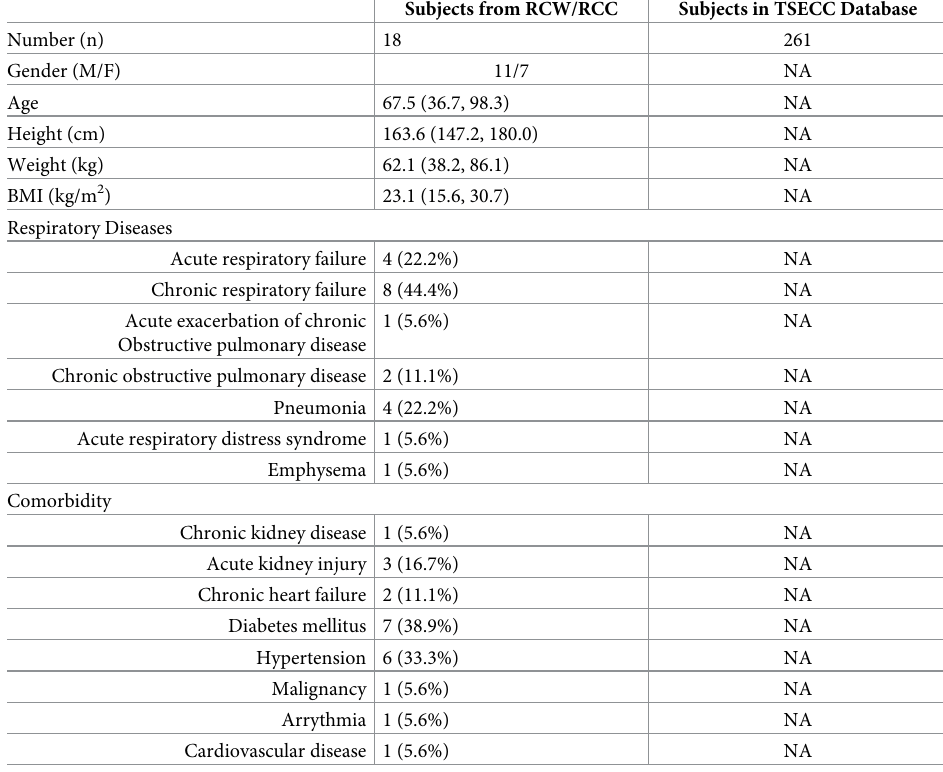
Table 1. Demographic data of